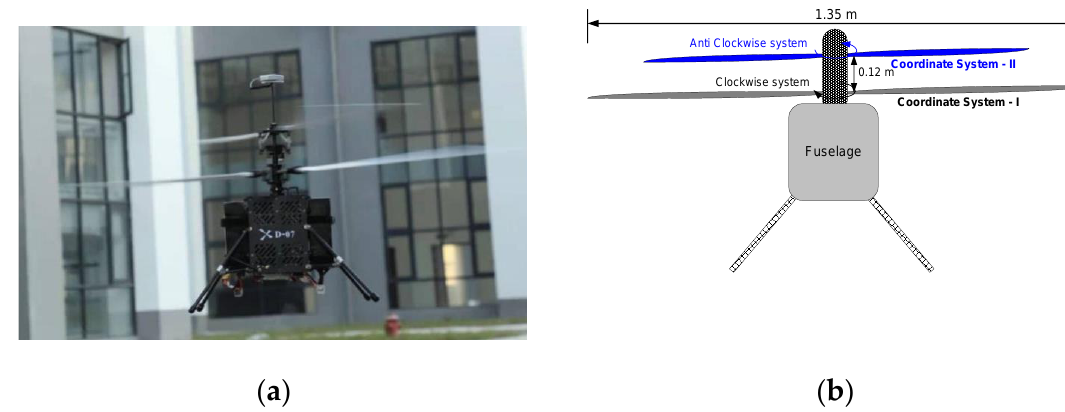
Figure 1. ( a ) Experimental flight test. ( b ) Schematic of the configuration.